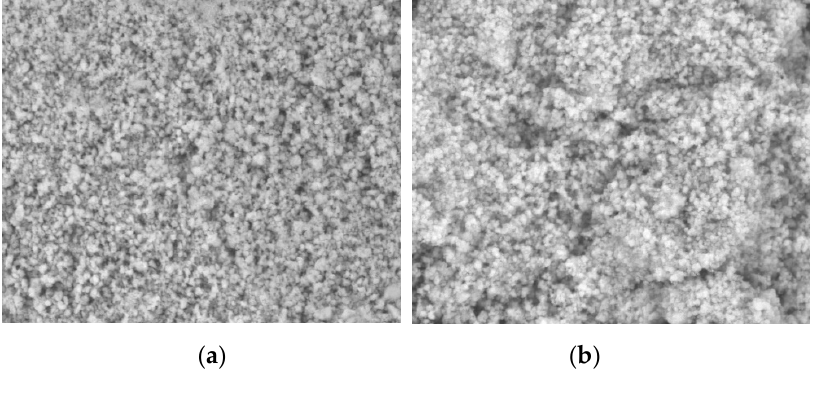
Figure 4. SEM image of ( a ) TS0 and ( b ) TS-3-400.